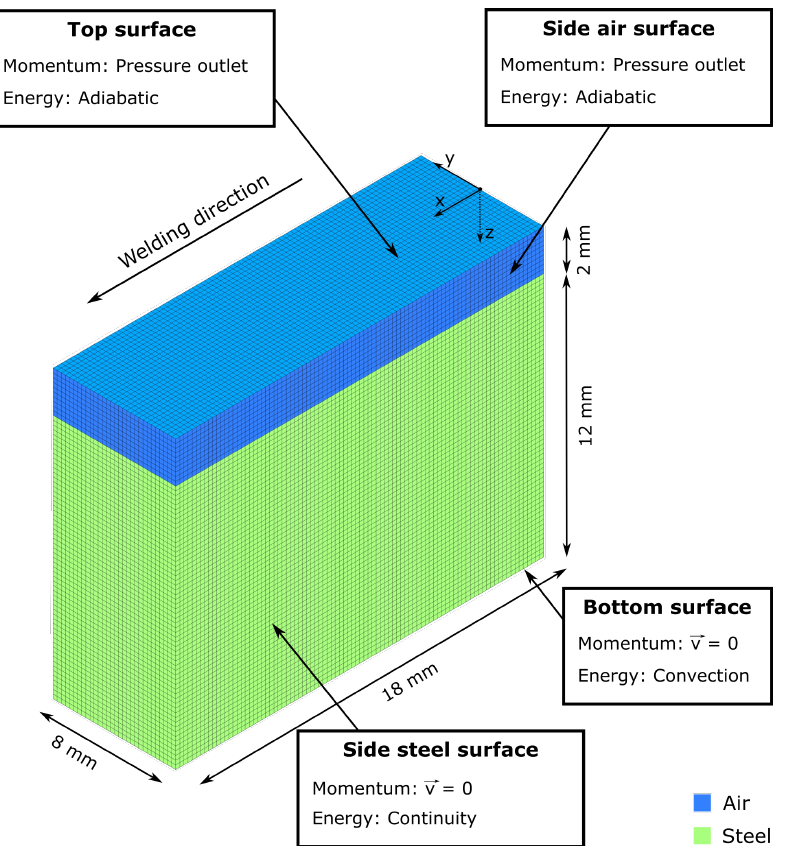
Figure 4. Boundary conditions of the multi-physics